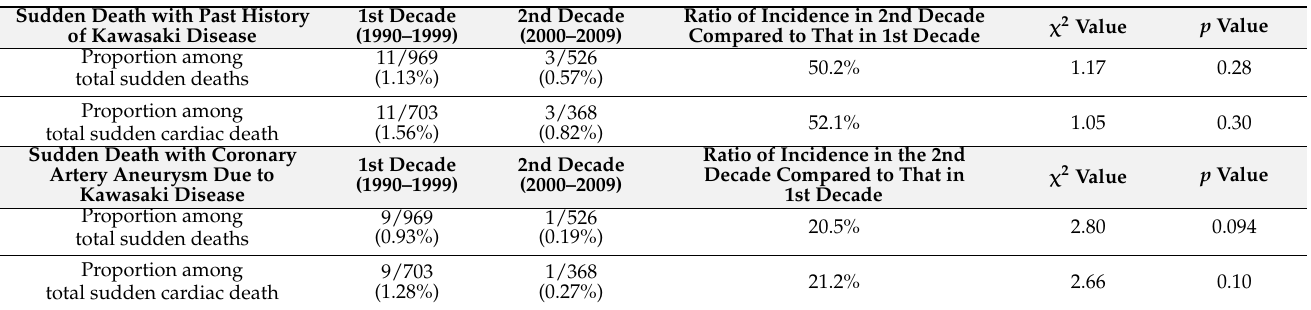
Table 3. Comparison of proportion of students with a history of Kawasaki disease among all sudden deaths or sudden cardiac deaths under school